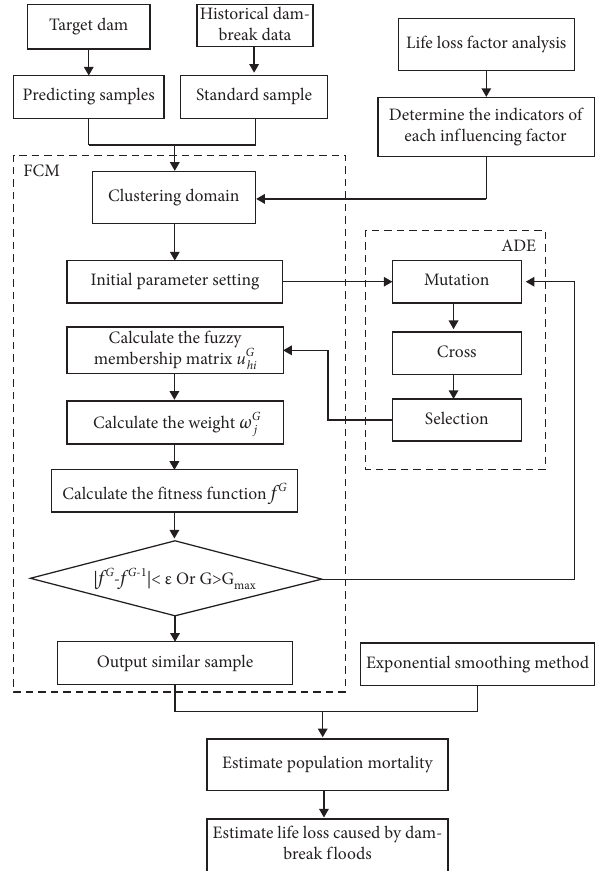
Figure 3: Calculation flow